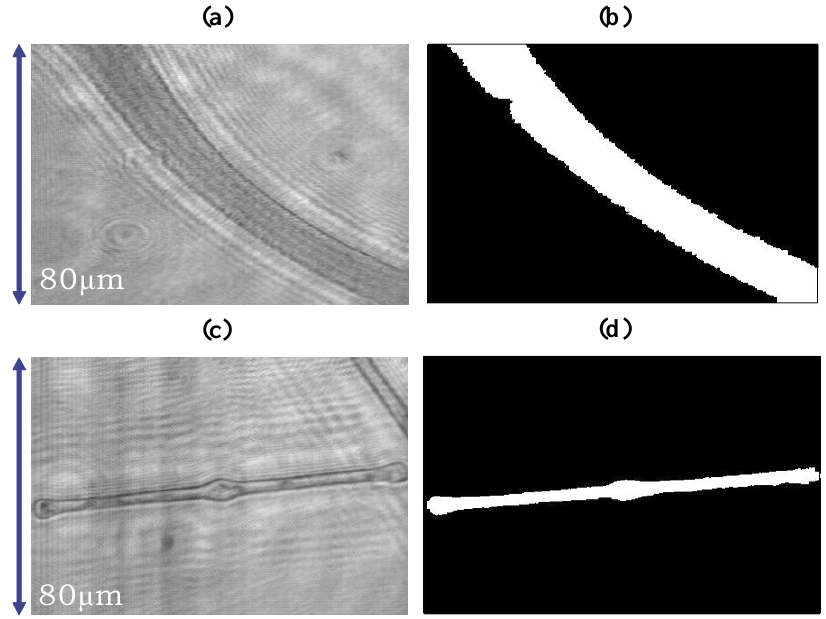
( Oscillatoria bacteria). (c) Diatom alga. (d) Binary window for target ( Diatom alga).